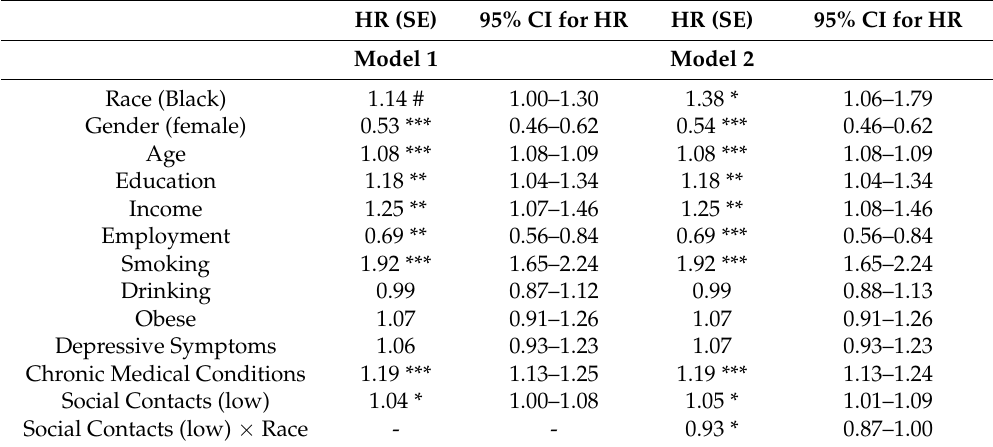
Table 2. Association between baseline social engagement and all-cause mortality overall.